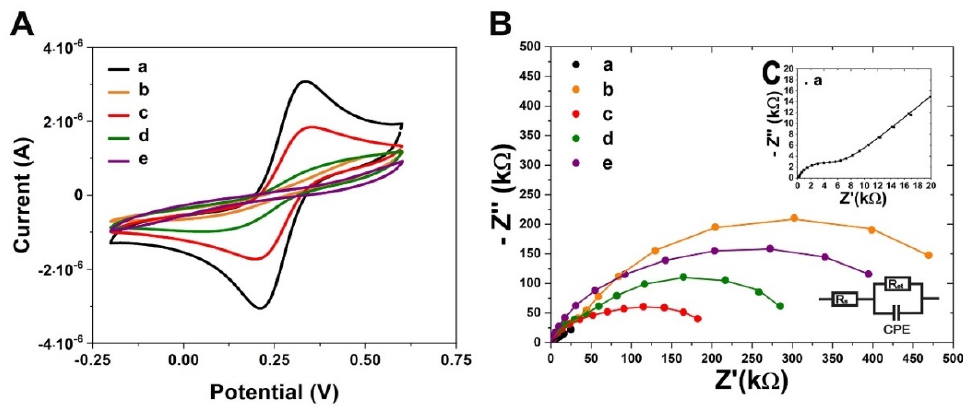
Figure 5. ( A ) Cyclic voltammetry (CV) curves, and ( B , C ) electrochemical impedance spectra (EIS) recorded after each step of the Au electrode modifications: (a) bare Au electrode; (b) TBBT SAM deposition; (c) immobilization of the metal nanoparticle colloids AuNPs; (d) immobilization of half-IgG; (e) deposition of BSA. Measuring conditions of EIS: applied frequencies from 0.01 Hz —100 kHz with the bias potential at 0.17 V in 10 mV of ac amplitude. The EIS spectra were fitted to the Nyquist plots for an electrical circuit model, which included R s —solution resistance; R et —electron transfer resistance; and CPE—constant phase element. Composition of used electrolyte: 0.1 M PBS, pH 7.4 with Table 1. Summary of the fitting results from the EIS plots through the Randles electrical circuit. Samples R et ( Ω ) R s ( Ω )